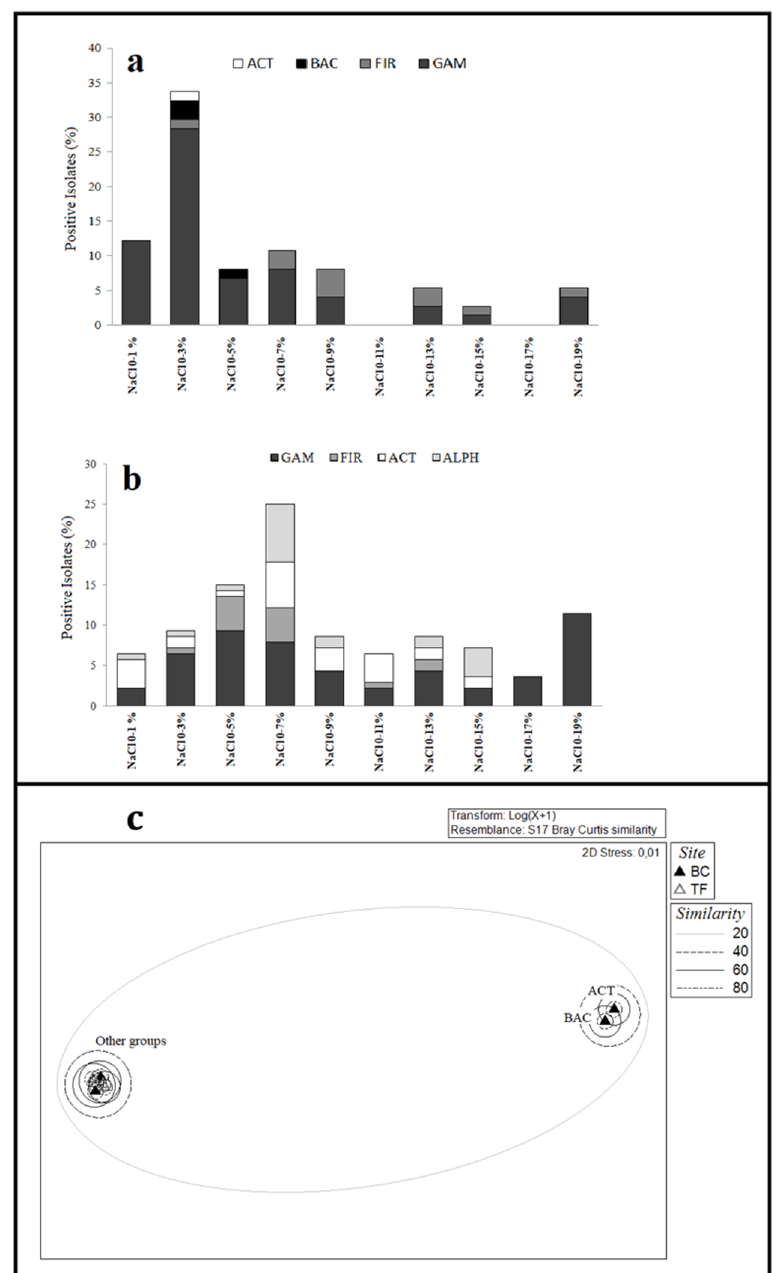
Figure 4. Bacterial growth at di ff erent salinity values for Boulder Clay brines ( a ) and Tarn Flat brines ( b ). Nonmetric multi-dimensional scaling analysis (nMDS) computed on transformed and clustered data by imposing the sampling site as a factor ( c